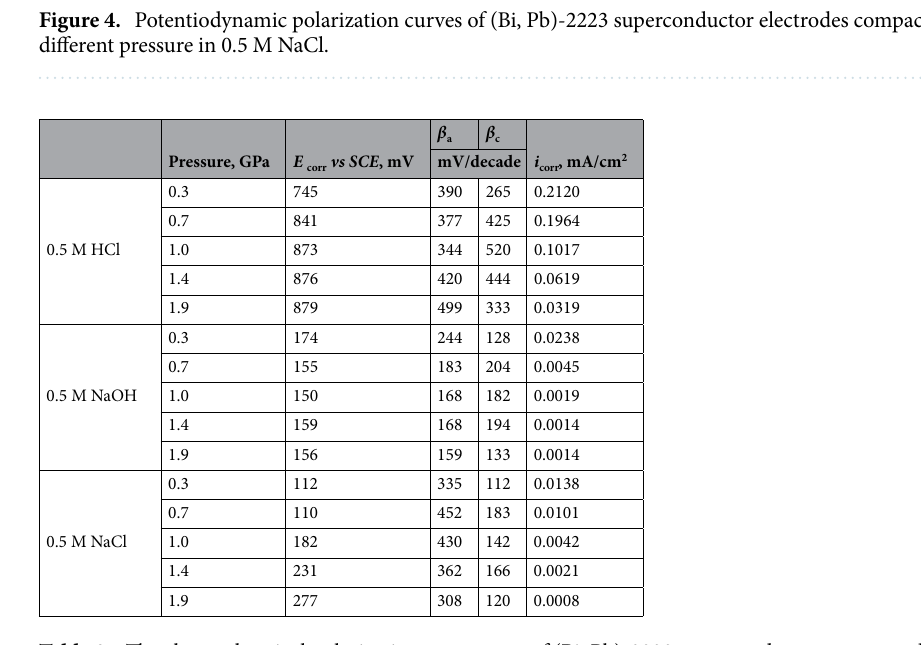
Table 3. The electrochemical polarization parameters of (Bi, Pb)-2223 superconductor compacted at different pressure in 0.5 M HCl, 0.5 M NaOH and 0.5 M